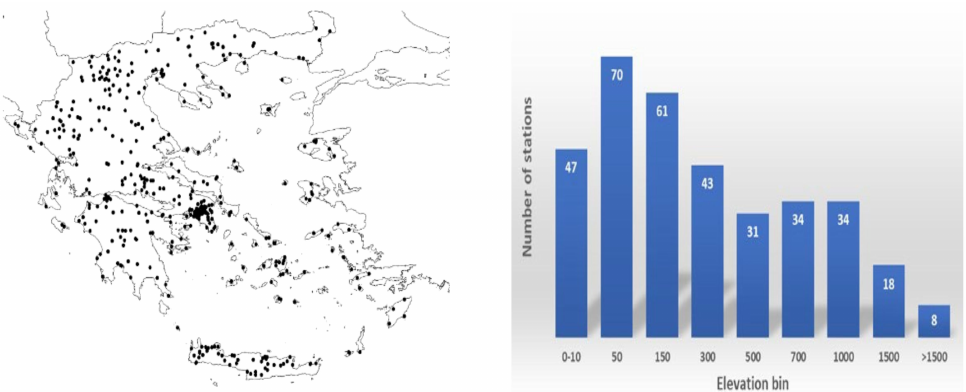
Figure 2. Geographical distribution of surface stations used to generate gridded precipitation fields ( left ), histogram of elevation distribution of stations ( right